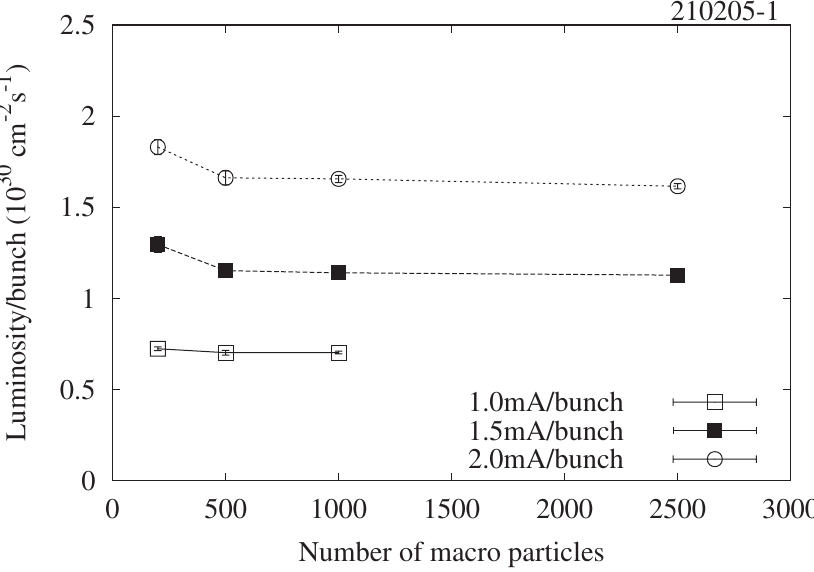
FIG. 5. Luminosity as a function of number of weak beam macroparticles for various bunch